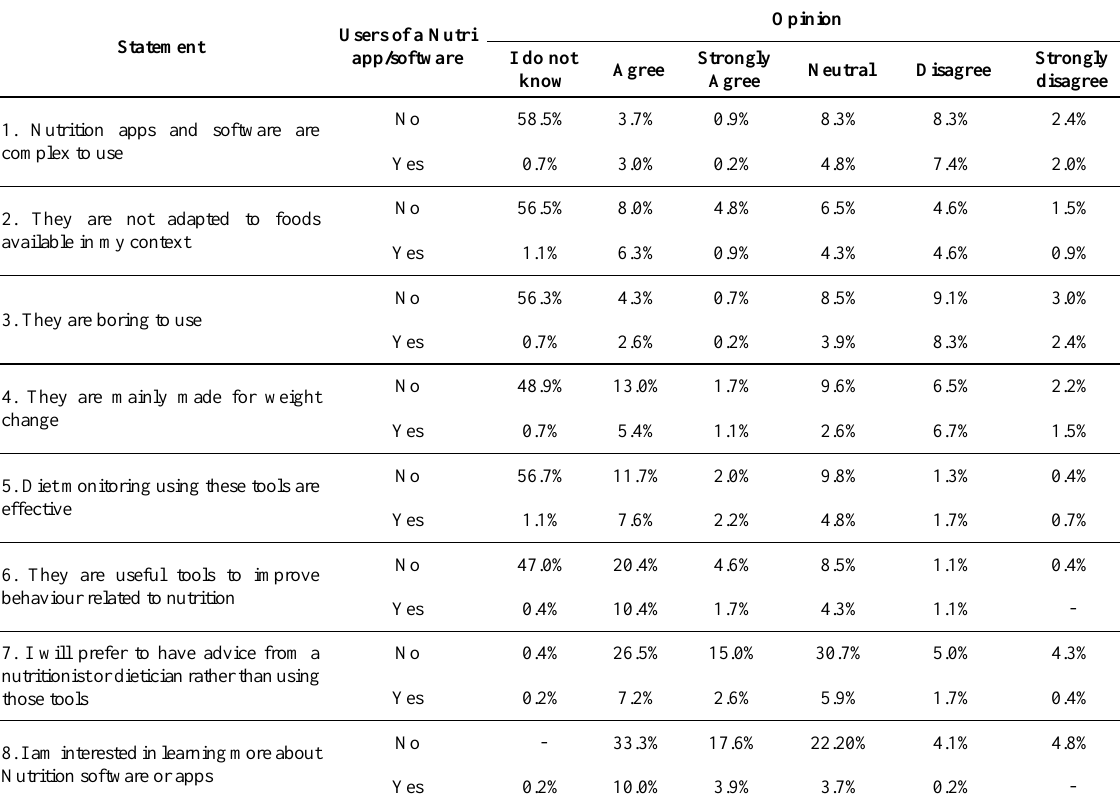
Table 4. Users and non-users opinion concerning Nutri Apps and software (N=460)